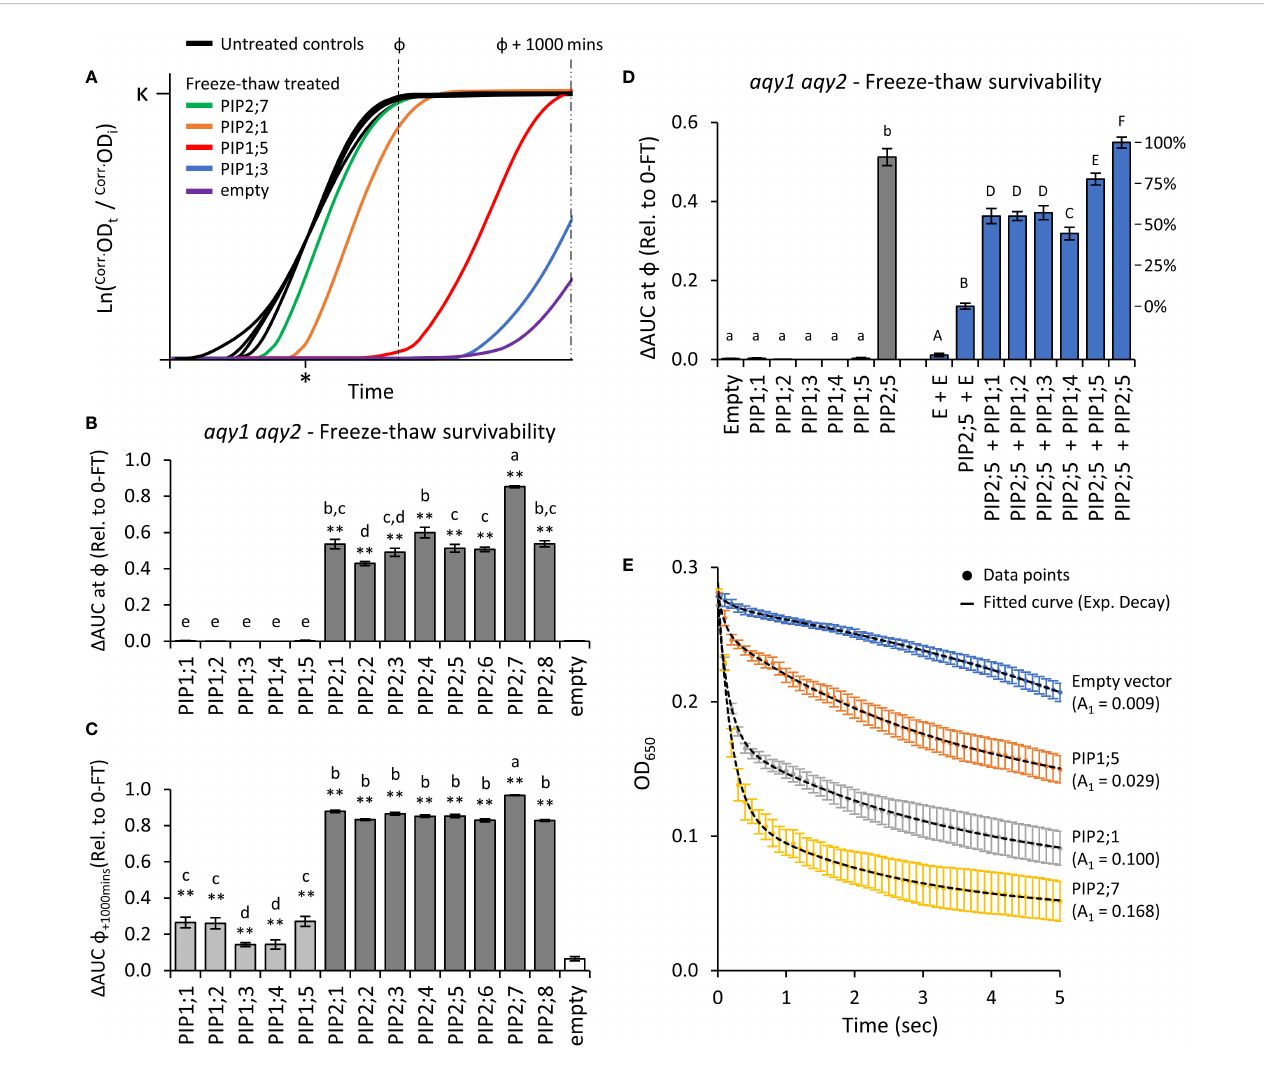
FIGURE 4 Water permeability assays using two freeze-thaw cycles with yeast expressing different AQP genes. (A) , Growth curves for untreated controls and following two freeze-thaw cycles. For illustrative purposes the untreated curves have been standardized to a fi xed lag-point (*) and the treated curves remain relative to their respective control. (B) , Relative AUC for the 13 AtPIP isoforms, calculated with ф . (C) , Relative AUC after extended growth with AUC calculated at ф +1000. (D) , Relative AUC for AtPIP1s expressed singly or co-expressed with AtPIP2;5. (E) , Change in OD of yeast spheroplast suspensions following osmotic shock. The contribution of the rapid initial phase (A 1 value in parentheses) re fl ects the permeability derived from fi tted two-phase exponential curves; empty vector: y = [0.00881 (cid:129) e (-x/0.243) ] + [-0.05398 (cid:129) e (-x/-6.47128) ]; AtPIP1;5: y = [0.02937 (cid:129) e (-x/0.09966) ] + [0.13874 (cid:129) e (-x/ 3.76055) ]; AtPIP2;1: y = [0.10037 (cid:129) e (-x/0.15797) ] + [0.10763 (cid:129) e (-x/3.51469) ]; AtPIP2;7: y = [0.16814 (cid:129) e (-x/0.18973) ] + [0.07791 (cid:129) e (-x/2.43538) ]. All error bars are SEM. For (B, C) , asterisks indicate statistical difference from empty vector control, ANOVA with Fishers LSD test (* P < 0.05; ** P < 0.01); letters denote different statistical rankings, ANOVA with Tukey ’ s test ( P < 0.05). For D, letters denote different statistical groupings, lowercase among single expressed and uppercase among co-expressed AtPIP yeast lines, ANOVA with Tukey ’ s test ( P < 0.05). N = 12 (AtPIP1s) and 8 (AtPIP2s) across 4 experimental runs for (B) and (C) . N = 6 across 3 experimental runs for D. N = 6 across 2 experimental runs for (E)